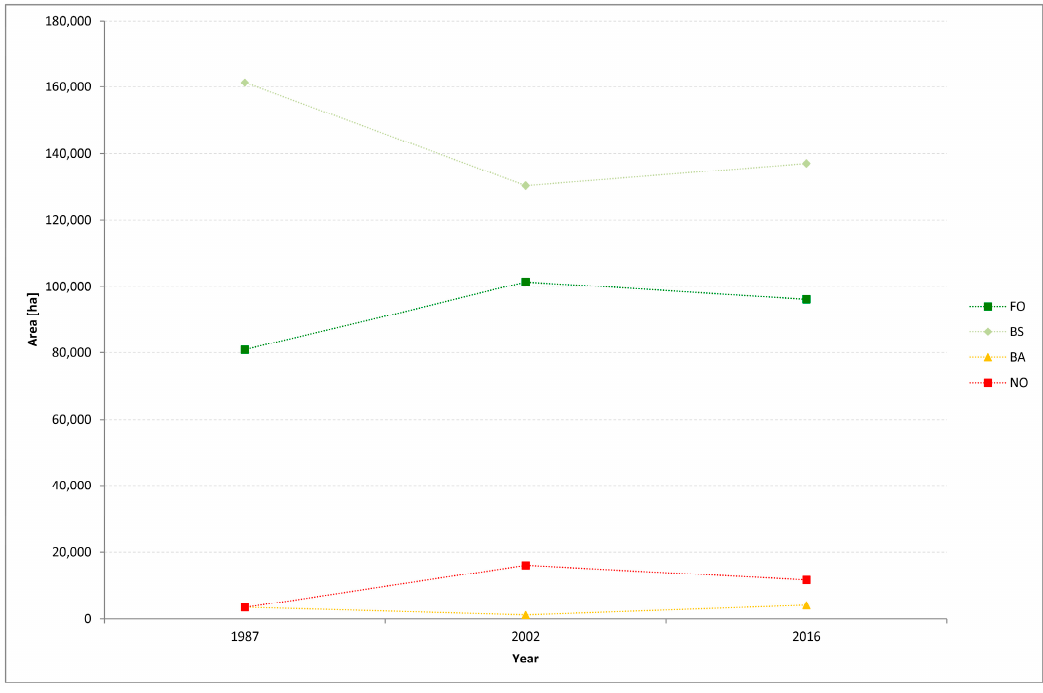
Figure 8. Area (ha) covered by each of the four woody biomass categories in 1987, 2002, and 2016. FO = high forest cover, BS = mostly bush- and shrubland, BA = little woody biomass, NO = no woody biomass.